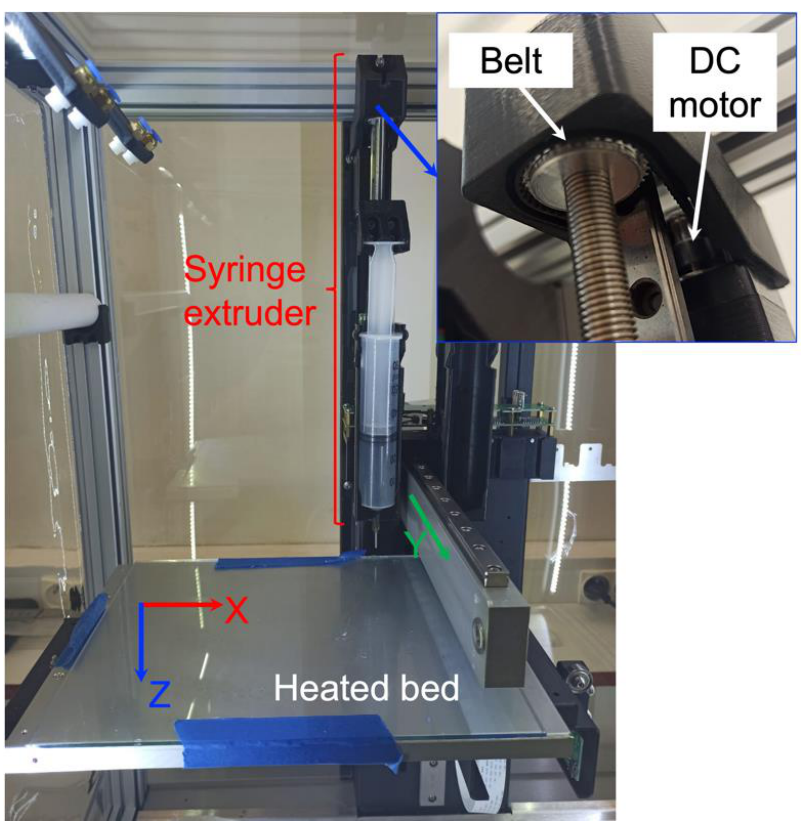
Figure 2. The Hyrel System 30 M 3D printer used in this work.